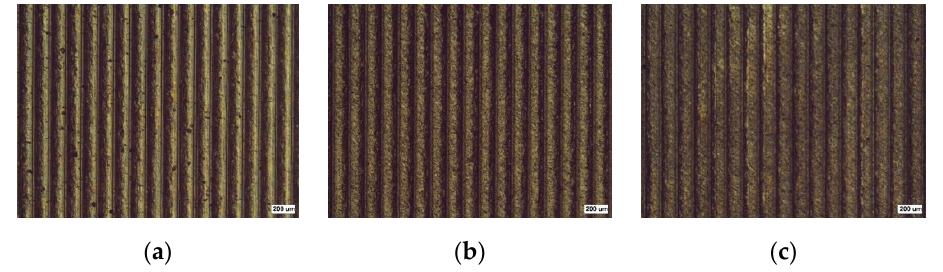
Figure 2. The effect of the static load in UNSM treatment on the appearance of Alloy 600 by optical microscope (×50): ( a ) 10 N; ( b ) 30 N; ( c ) 50 N.